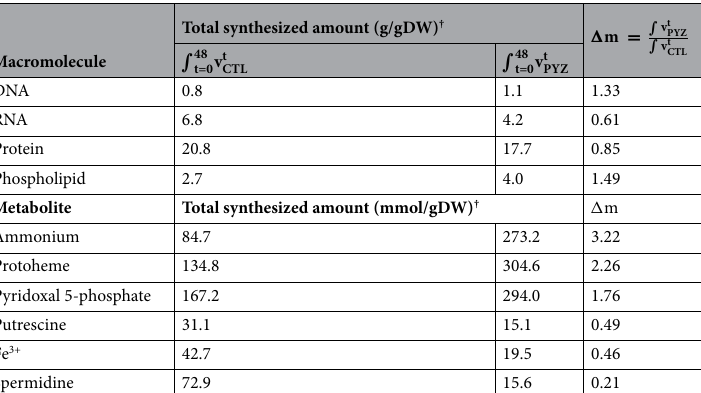
Table 3. Macromolecules and metabolites accumulated in untreated and pyrazoleamide-treated parasites. gDW gram dry weight of the parasite. † We computed the total accumulated amount of a macromolecule (or metabolite) by numerically integrating their synthesis rate (v) over the 48-h intraerythrocytic developmental cycle under untreated (CTL) or pyrazoleamide (PYZ)-treated